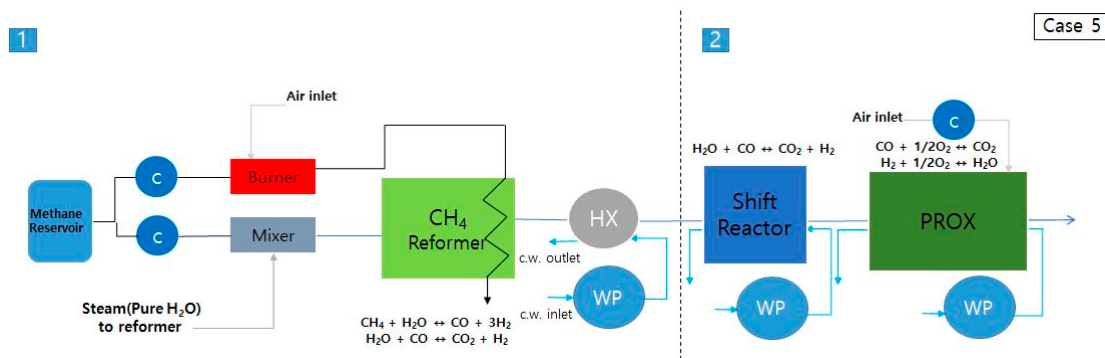
Figure 8. Schematic of Case 5 reforming system. Table 7. Results for (WGS + PROX reactor) outlet side.